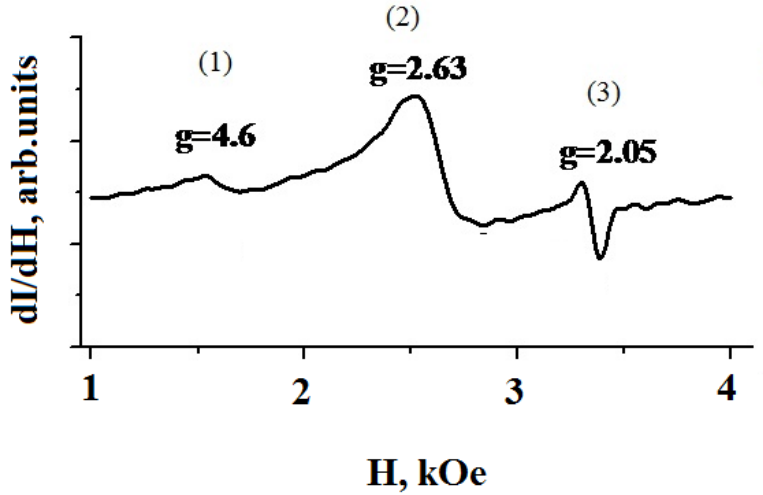
Figure 2. Electron paramagnetic resonance (EPR) spectra of ferriin in frozen BZ solution at 100 K.